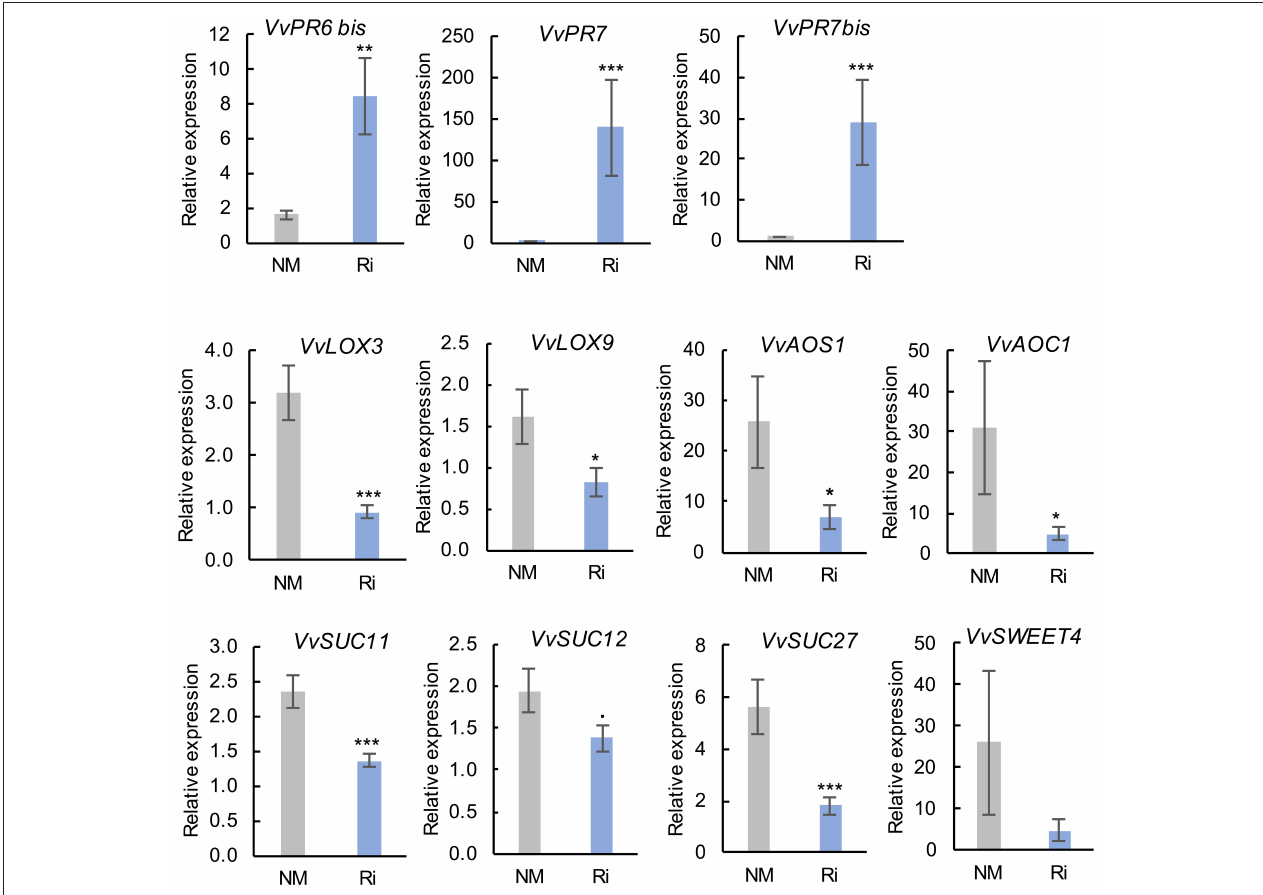
FIGURE 8 | Expression of genes related to defense responses and sugar transport and metabolism in roots of NM and Ri plants. Expression was studied by RT-qPCR in root tips 2 months after mycorrhization. Transcript levels were normalized to V. vinifera ACTIN and EF1 α transcript levels. For each gene, relative expression was obtained with the 2 − 11 CT method and indicates mean normalized expression in the different conditions compared with normalized expression in the plant showing the lowest expression level (highest CT value), which was set to 1. Data are the mean ± SE of 12 independent biological replicates for VvLOX3 , VvLOX9 , VvAOS1 , VvSUC11 , VvSUC12 , and VvSUC27 . Data are the mean ± SE of six independent biological replicates for VvSWEET4. Asterisks indicate significant difference in gene expression between NM and Ri conditions (Kruskall and Wallis, *** p < 0.001, ** p < 0.01, * p < 0.05, · p <